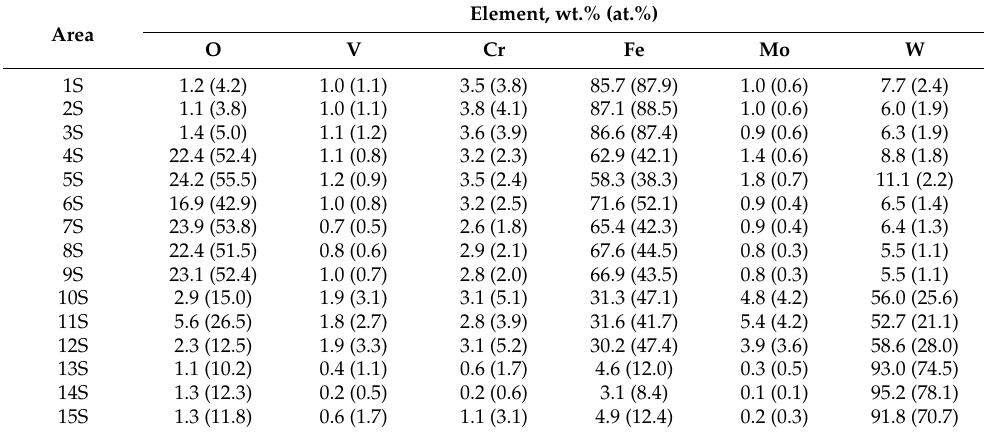
Table 4. EDS elemental composition of the M2/W worn surface after sliding at 2.4 m/s (Figure 11f).